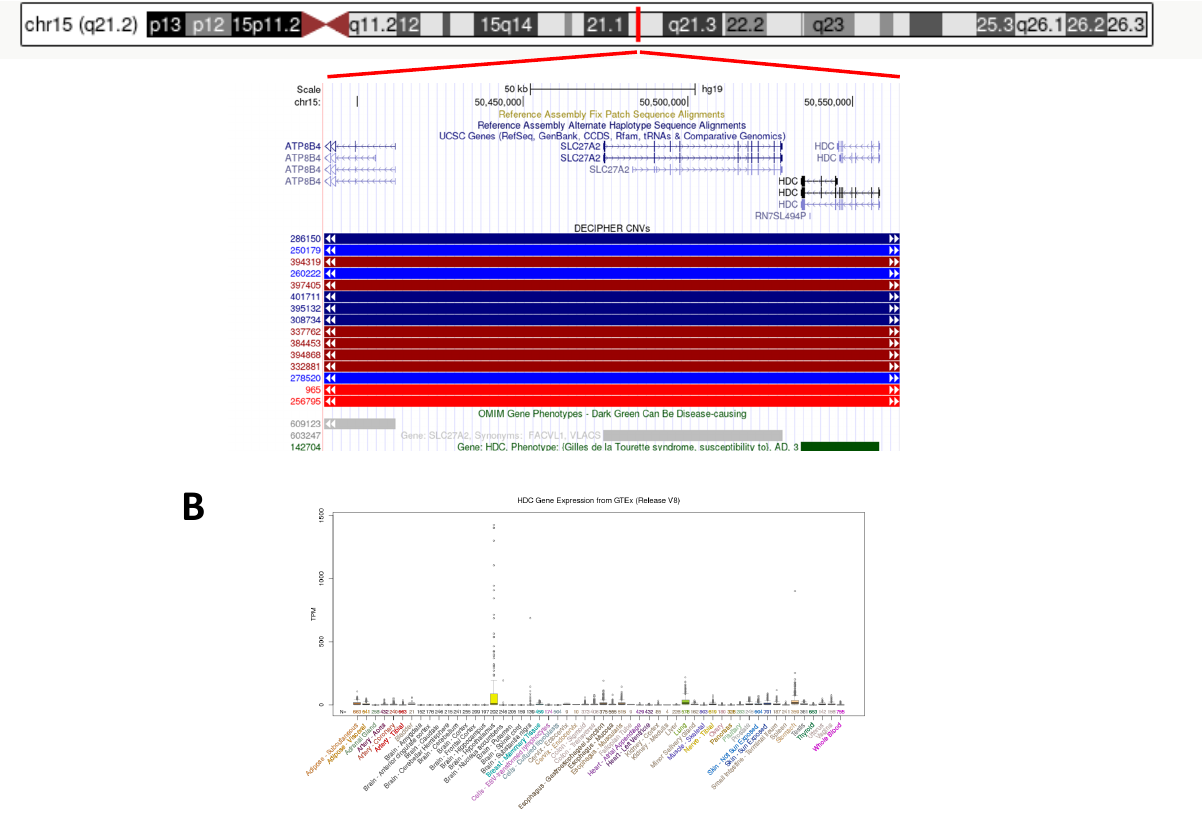
Figure 1. ( A ) Chromosomal location of the 15q21.2 deletion and its gene content. ( B) Tissue expression profile of the HDC gene taken from the GTEx